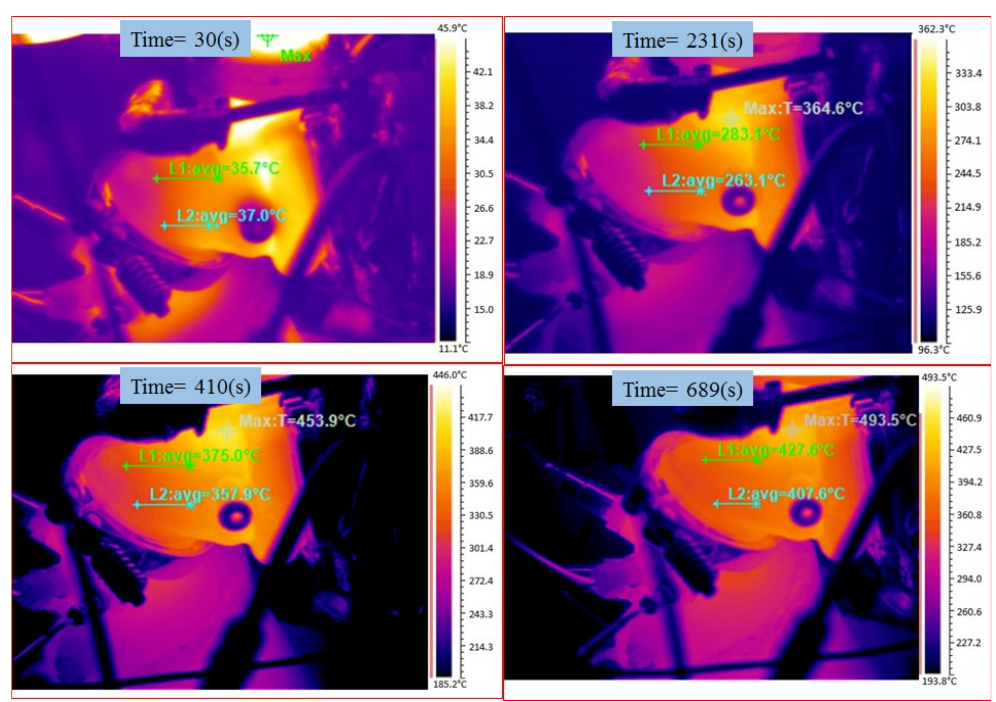
Figure 17. Variation in turbine housing warm-up temperature with time, based on data of the ther- mal camera.